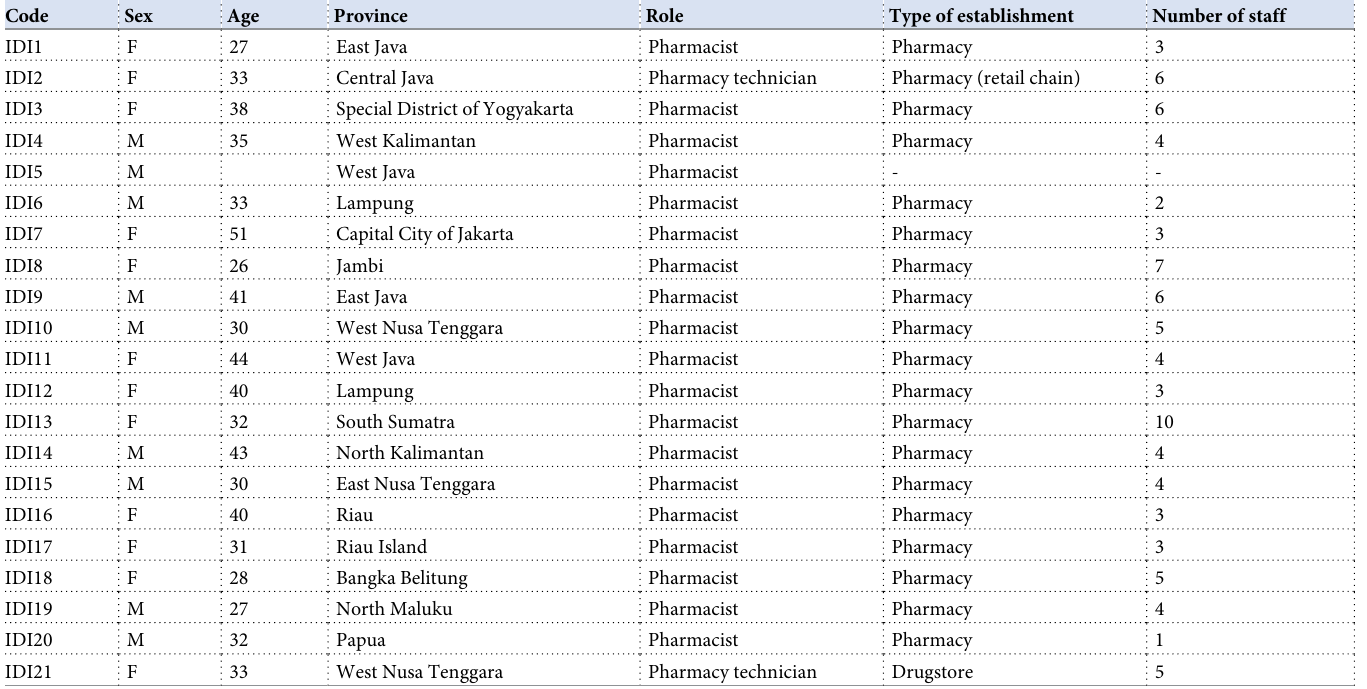
Table 1. Characteristics of